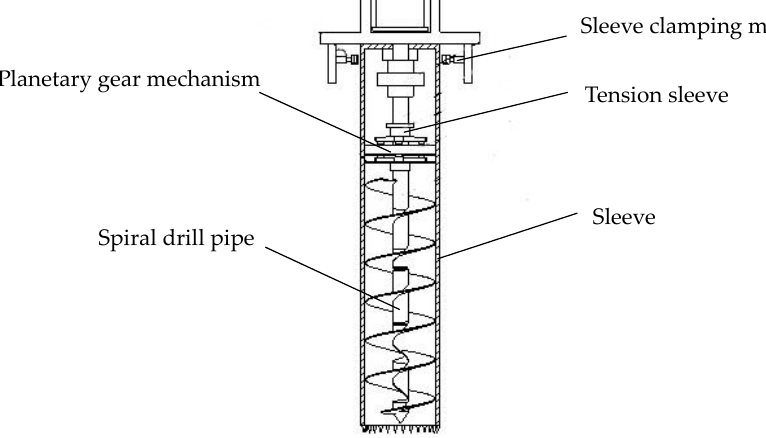
Figure 32. New tree-planting machine concept structure.